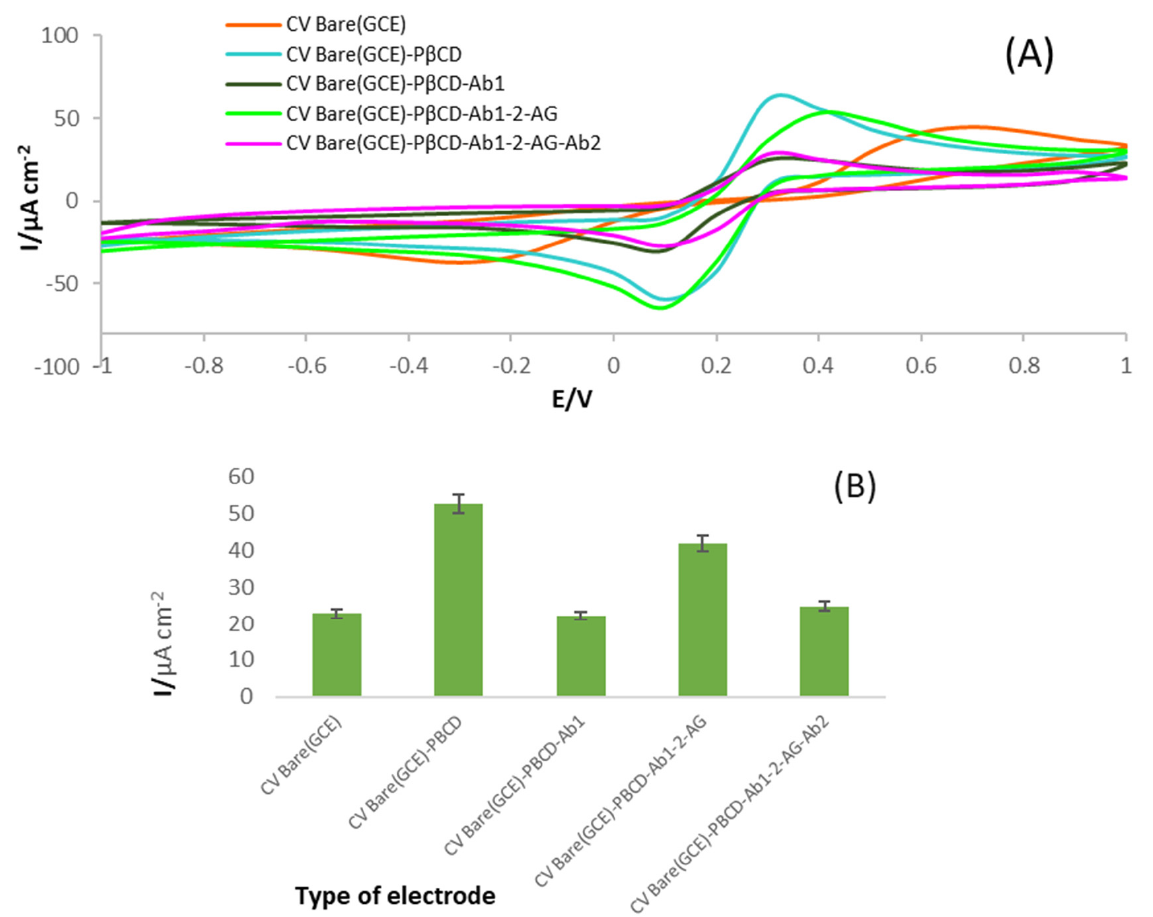
Figure 2. ( A ) CVs of the GCE, the P( β -CD)-modified GCE, the Ab1/P( β -CD)-modified GCE, the 2-AG/Ab1/P( β -CD)-modified GCE, and the HRP-Ab2/AuNPs/TB/GLU/2-AG/Ab1/P( β -CD)-modified GCE in a solution containing 0.03 M K 4 Fe(CN) 6 /K 3 Fe(CN) 6 /KCl in a potential range of − 1 V to 1 V at a scan rate 0.1 V/s. ( B ) Histogram of the peak current versus the type of electrode.